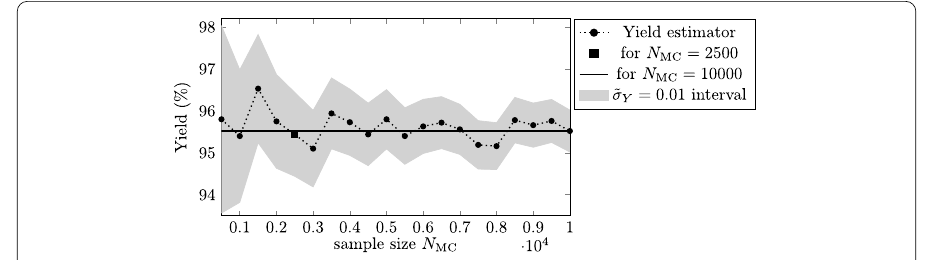
Figure 2 Values of MC yield estimators for different sample sizes N MC . The gray shaded area indicates the corresponding ˜ σ Y interval for each sample